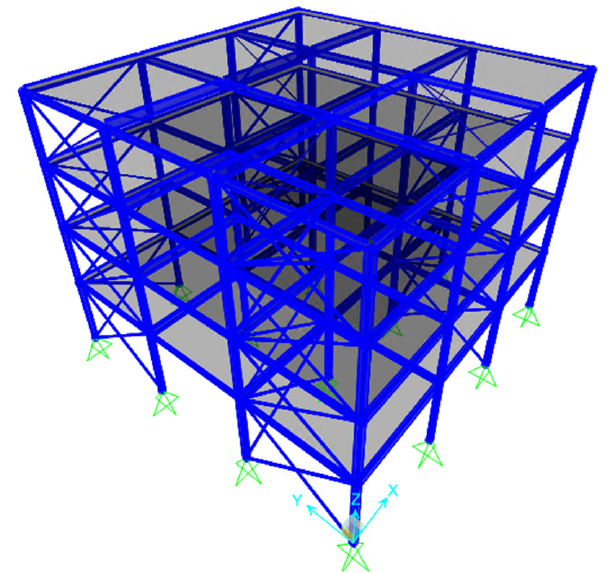
Figure 22. Multi-storey building model with SAP2000 for case studies 7 and 8. Table 19. Results of case study 7 (L: level; G: group; S: step).